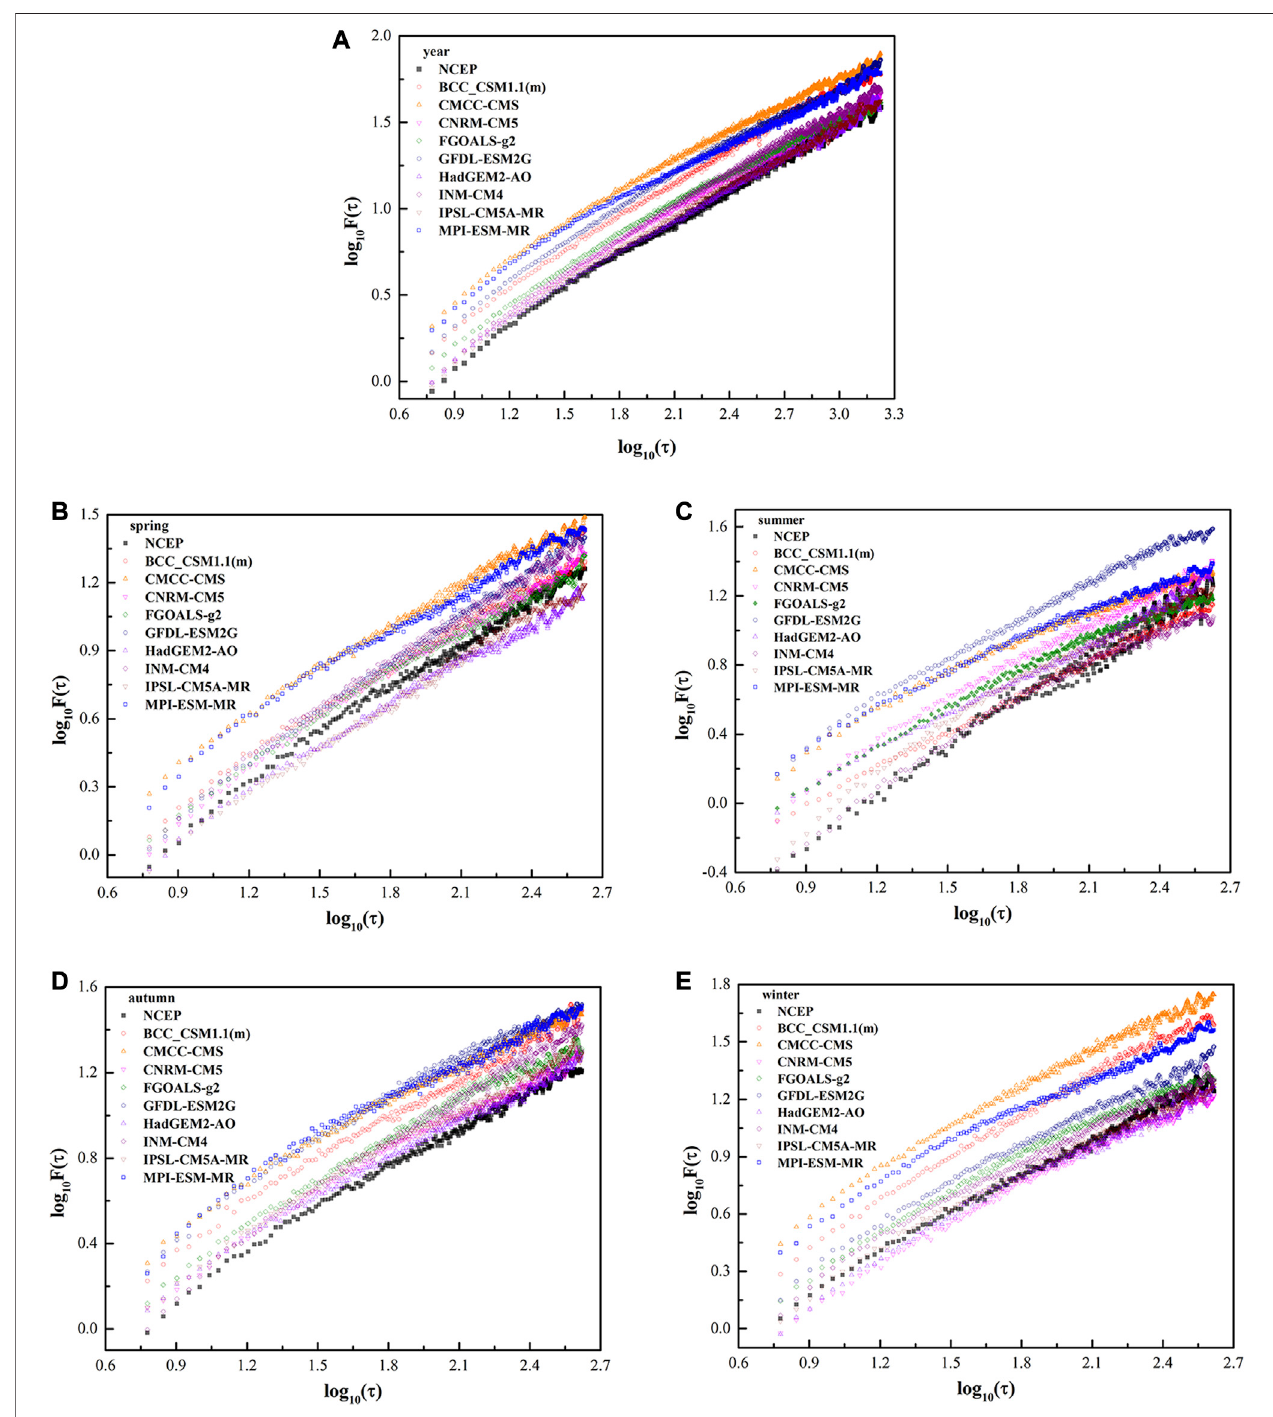
FIGURE 2 | The DFA2 results of daily precipitation from NCEP and CMIP5 models at the point of (110 ° W, 35 ° N) for (A) year, (B) spring, (C) summer, (D) autumn, and (E) winter.